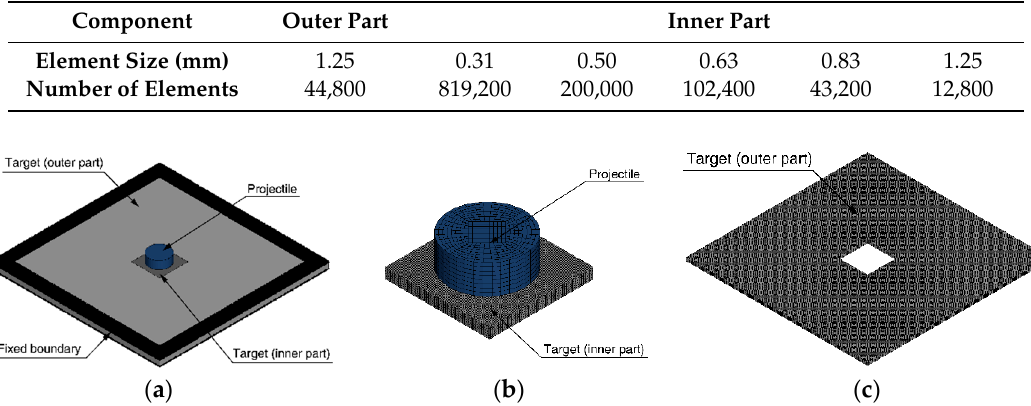
Figure 5. Numerical models of ( a ) projectile and target plate, ( b ) inner part, and ( c ) outer part of the target plate. Table 5. The number of elements for 5 mm plate model.